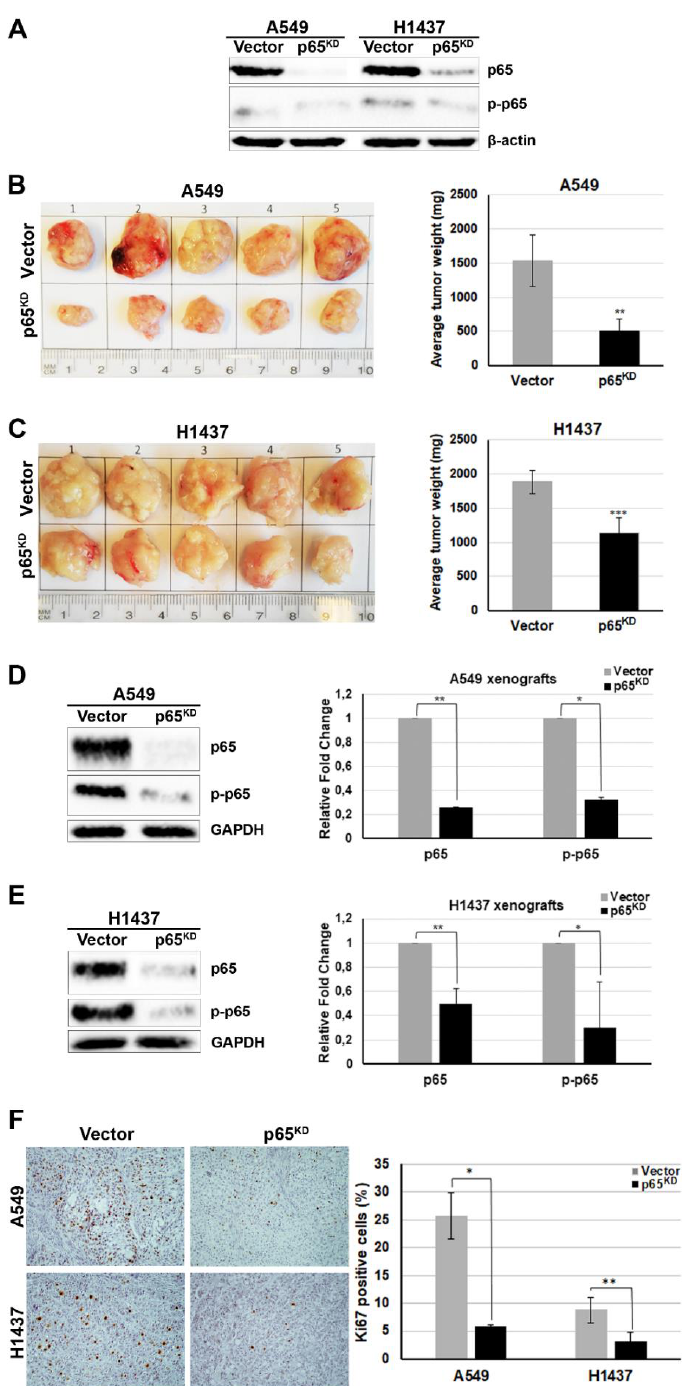
Figure 1. Canonical NF- κ B signalling is required for the growth of human NSCLC in murine xenografts. ( A ) Generation of RelA/p65-compromised A549 and H1437 human lung cancer cells. Cells were transfected with either the control vector pSuper-Puro or a pSuper-Puro-sh65 carrying a shRNA against RelA/p65 (p65 KD ) and selected in puromycin to generate stable cell lines. Total proteins extracted were analysed by immunoblotting for the expression of RelA/p65, or β -actin as a reference control. ( B , C ) A549 and H1437 cells and their RelA/p65 KD derivatives grown in vivo as tumour xenografts. 2 ×